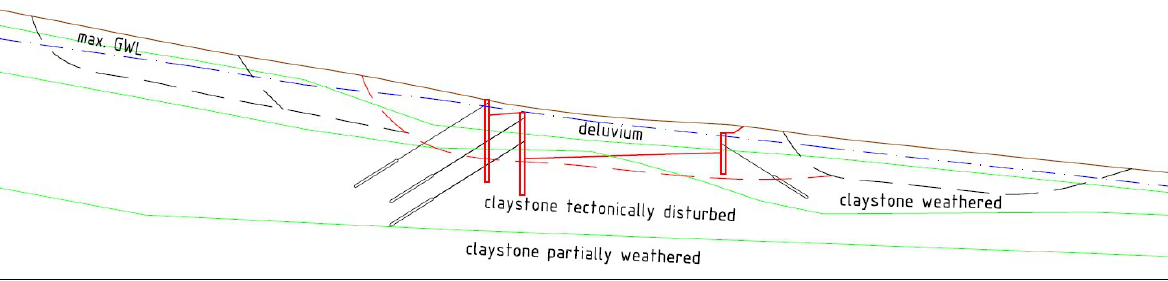
Figure 2. Geotechnical section 2 through